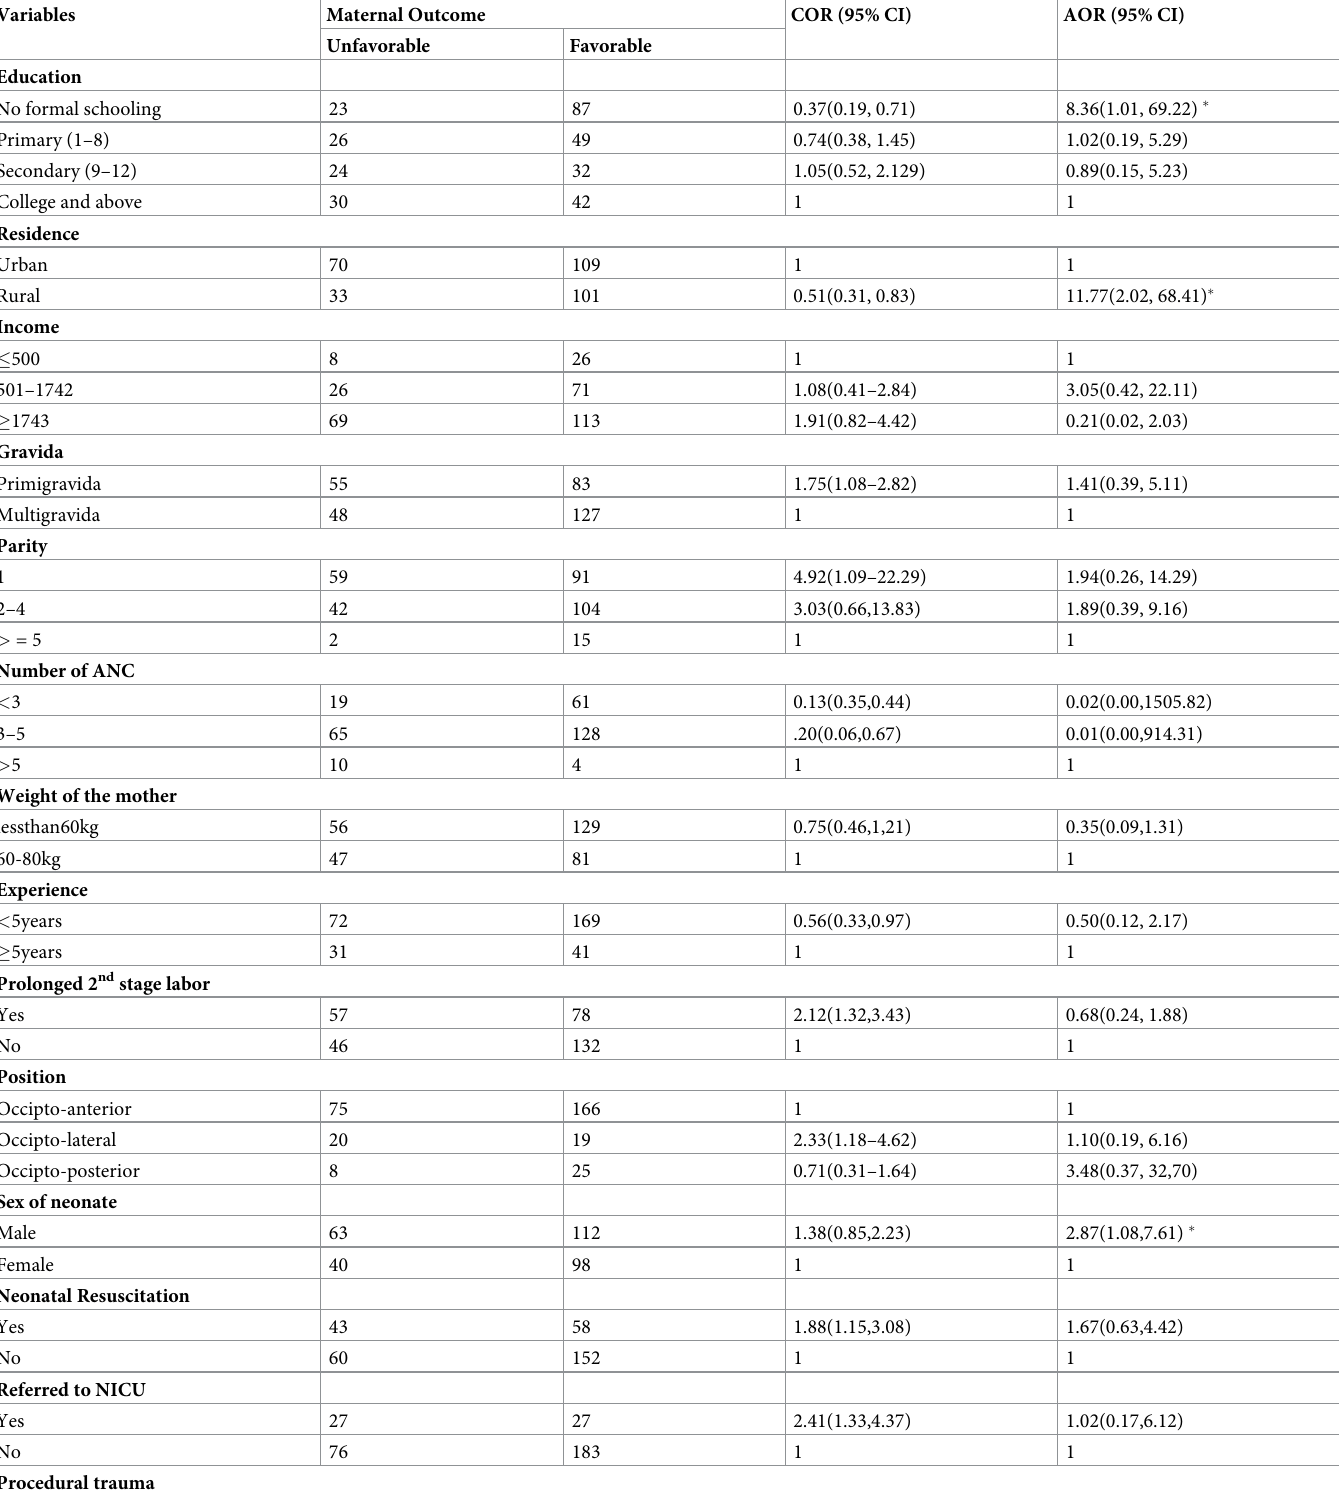
Table 3. Factors associated with unfavorable maternal outcomes of operative vaginal delivery in East Gojjam Zone Hospitals, Northwest